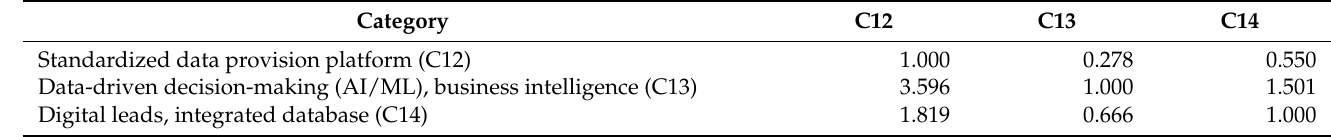
Table 14. Consolidated decision matrix for D4 sub-criteria.